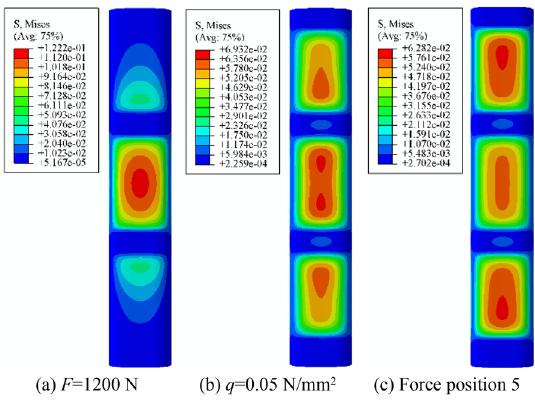
Figure 16 Comparison of contact stress under different load